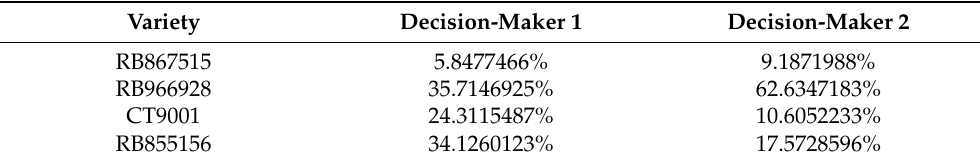
Table 5. Result of the AHP application with the preferences of both decision-makers for each sugarcane variety.